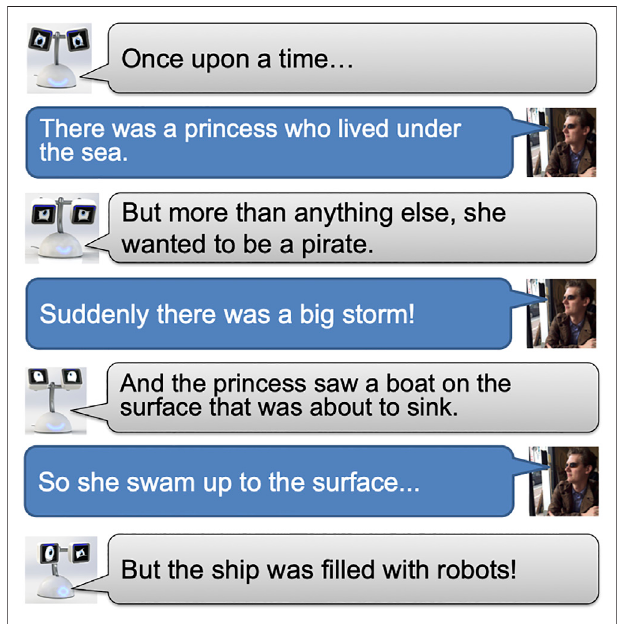
FIGURE 1 | Collaborative storytelling with an intelligent agent.